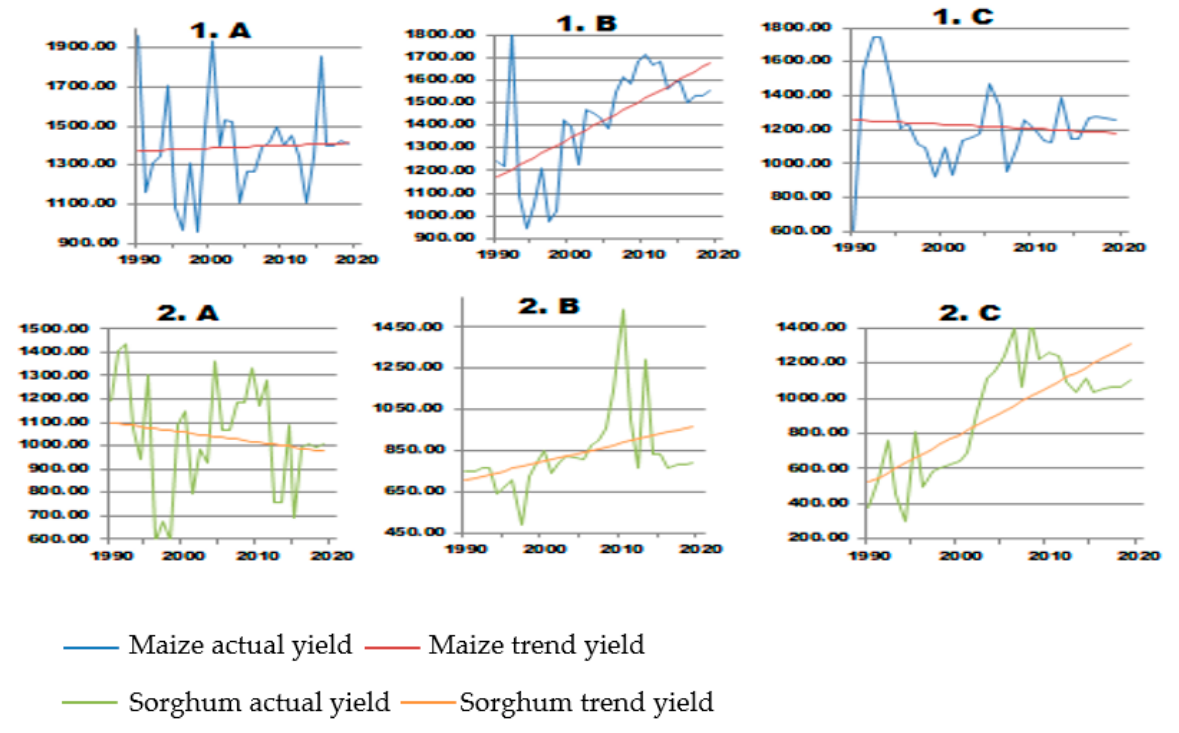
Figure 3. Actual yield and linear trend yield from 1990 to 2019 for maize and sorghum in the Plateau